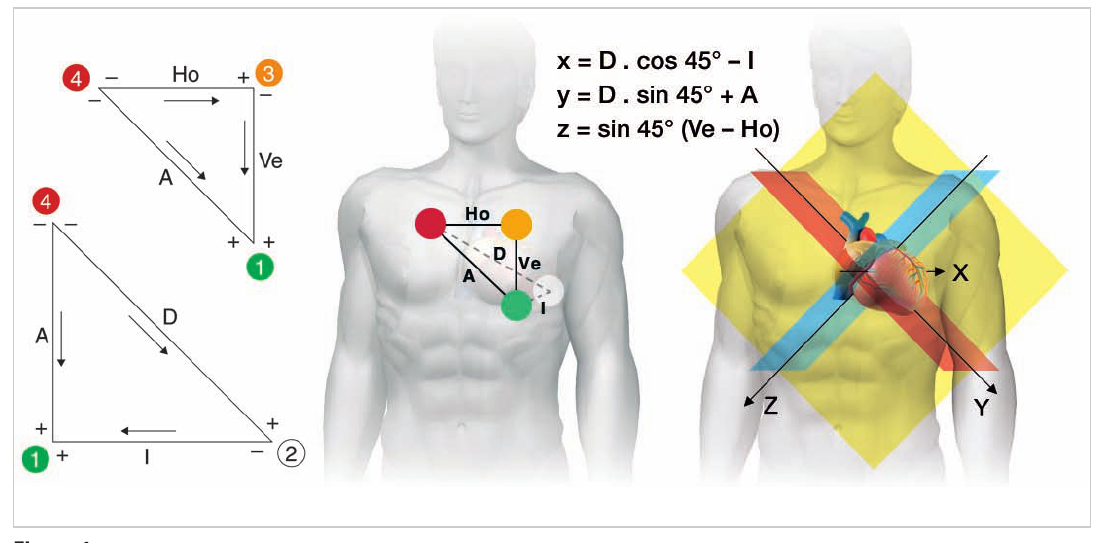
Principles of cardiogoniometry: Four electrodes are placed at four points on the patient’s thorax as follows: Point 1 (green) at point V4 of Wilson, ie, in the 5 th intercostal space in the mid-clavicular line; point 2 (white) sagittal to electrode 1 on the back (point V8 of Wilson); point 3 (yellow) is located perpendicularly above electrode 1 at 0.7 times the distance between points 1 and 2; point 4 (red) is placed to the right of point 3 at the same distance as between points 1 and 3. The leads are defined